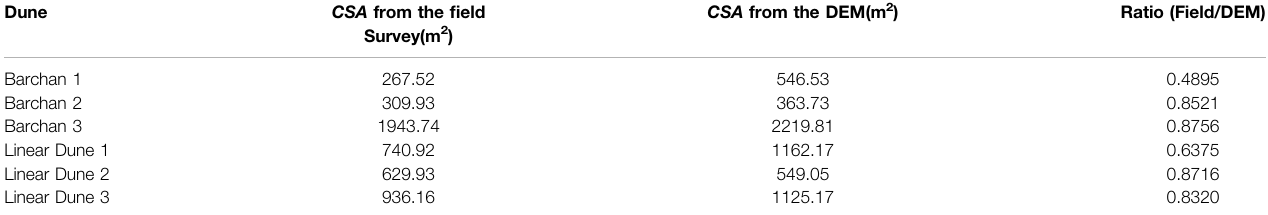
TABLE 2 | Comparison of the digital elevation model (DEM) and fi eld survey estimates of dune cross-sectional area ( CSA ) for the six dunes whose pro fi les are shown in Figure 7 . Dune CSA from the fi eld Survey(m 2 )